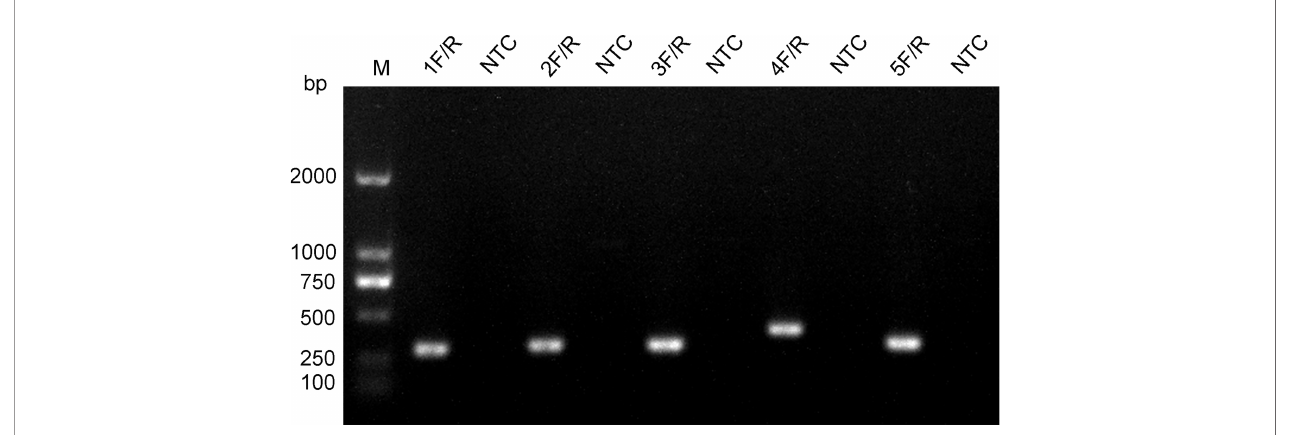
FIGURE 5 | Screening of primers. The name of each primer pair is provided above each lane. The NTC lane immediately after is the no-template control of the respective primer pair. The band sizes of the DNA ladder are shown on the left.